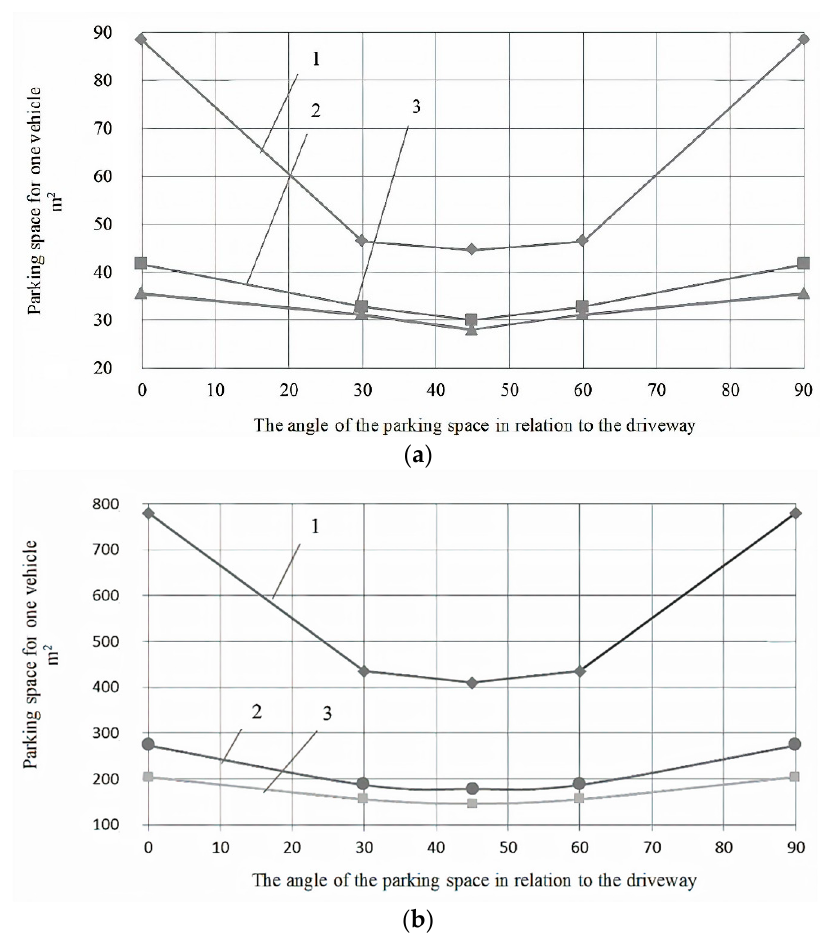
Figure 10. The required parking area at different angles of installation of vehicles and parking capacity: 1-one vehicle; 2–5 vehicles; 3–11 vehicles; ( a ) for passenger cars; ( b ) for road trains with the length of 16.5 m.